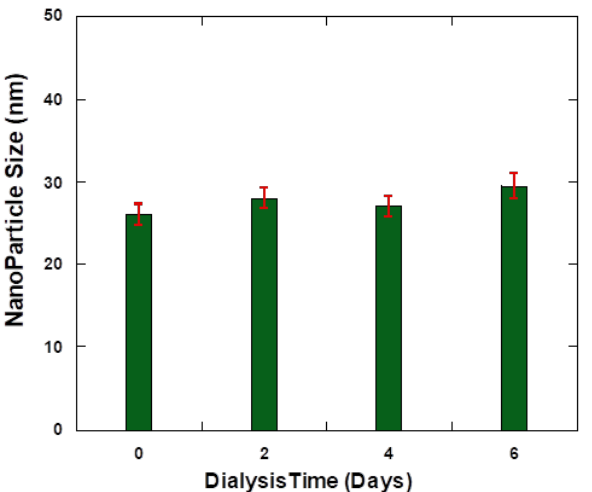
Figure 3. Particle size analysis of the SiNPs at several times during the first 6 days.